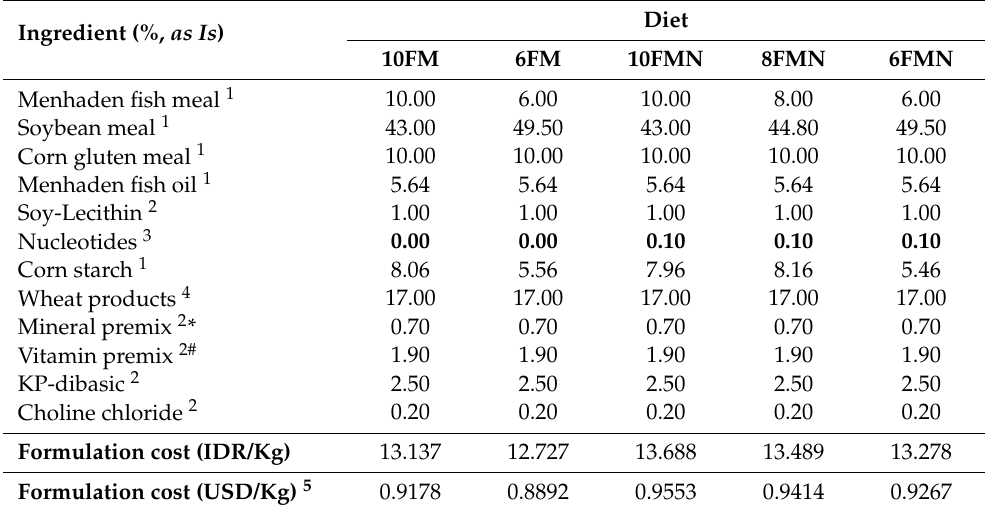
Table 1. Composition (%, as is ) of diets used in the study. Diets were administered to Pacific white shrimp (PWS) for 110 days, and were formulated using different levels (10%, 8% and 6%) of fish meal (FM), and with or without adding dietary nucleotides